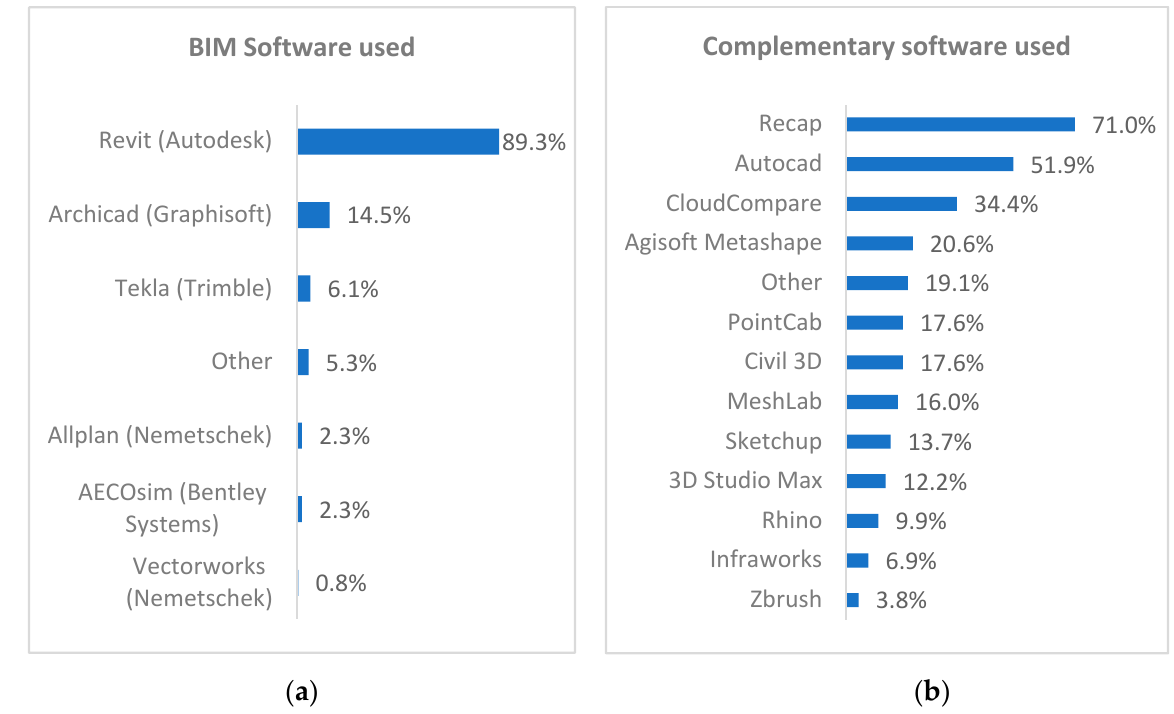
Figure 19. ( a ) Digital tools used in BIM modeling, ( b ) complementary digital tools used to assist the modeling phase.